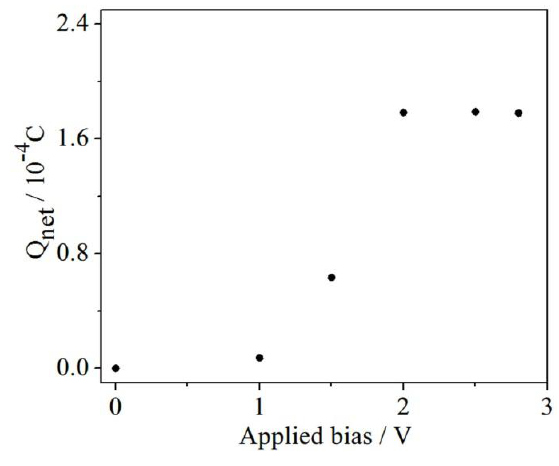
determination. net